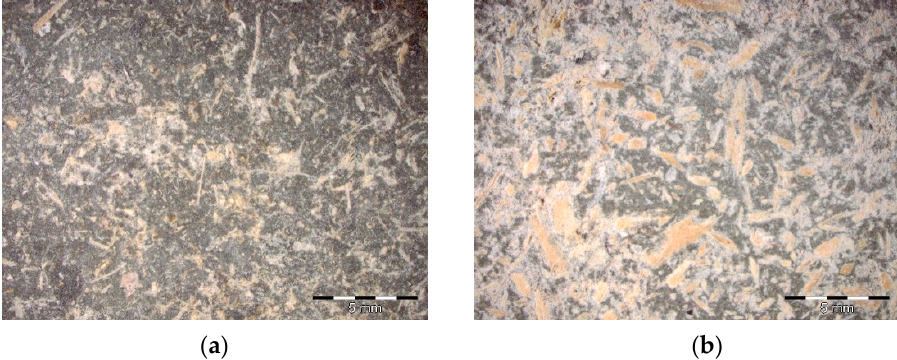
Figure 3. Examples of CBPB test specimens before fungal exposure ( a ) B50u unsanded; ( b ) B50p sanded.